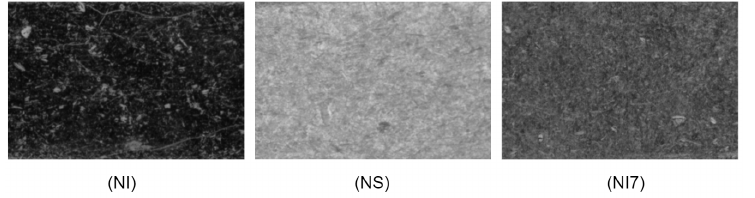
Figure 3. Zoom of a component region showing different texture image appearance caused by different coatings: nickel (NI), nickel–silver (NS) and Ni7 nickel–silver